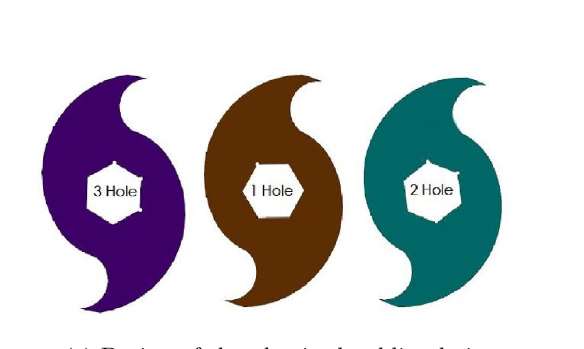
(a) Design of the plastic shredding knives.